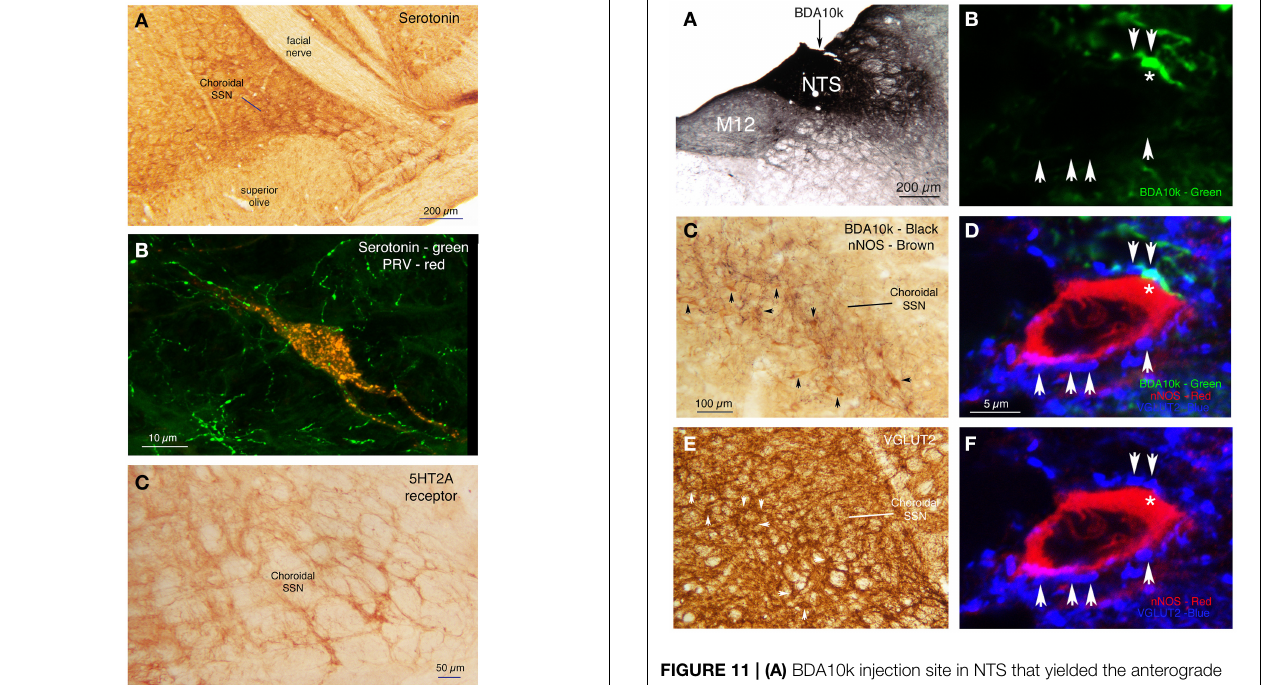
FIGURE 11 | (A) BDA10k injection site in NTS that yielded the anterograde labeling in SSN shown in (C) . (B) The green channel from a section triple labeled by immunofluorescence, in this image showing BDA10k + (green) terminal labeling from NTS. The red channel (showing nNOS labeling) and blue channel (showing VLUT2 labeling) are shown in (D,F) , respectively. Arrows indicate the location of blue VGLUT2+ terminals (shown in F ) contacting the red nNOS + perikaryon (shown in D ). (C) Two color DAB double labeling showing brown nNOS + prechoroidal neurons in SSN, overlapped by black BDA10k + fibers arising from NTS. Some of the brown nNOS + neurons are indicated by arrows. (D) Triple label immunofluorescence showing BDA10k + (green) terminals from NTS, making VGLUT2 + contacts (blue) on NOS + neurons (red) in SSN. Arrows indicate blue VGLUT2 + terminals contacting the red nNOS + perikaryon shown. The asterisk indicates a green oxytocinergic terminal (as seen in the green channel alone in B ) making contact with the red nNOS + perikaryon. The image in (F) Shows that this terminal co-contains VGLUT2. (E) Brown DAB immunolabeling showing that VGLUT2 terminals are present throughout the SSN region, but more enriched in prechoroidal SSN. Note that clusters of VGLUT2 + terminals in some cases appear to outline perikarya (arrows). (F) Same image as in (D) , but only showing the many VGLUT2 + contacts (blue) on NOS + neurons (red) in SSN. Scale in (C,E) is the same, and scale in (B,D,F) is the